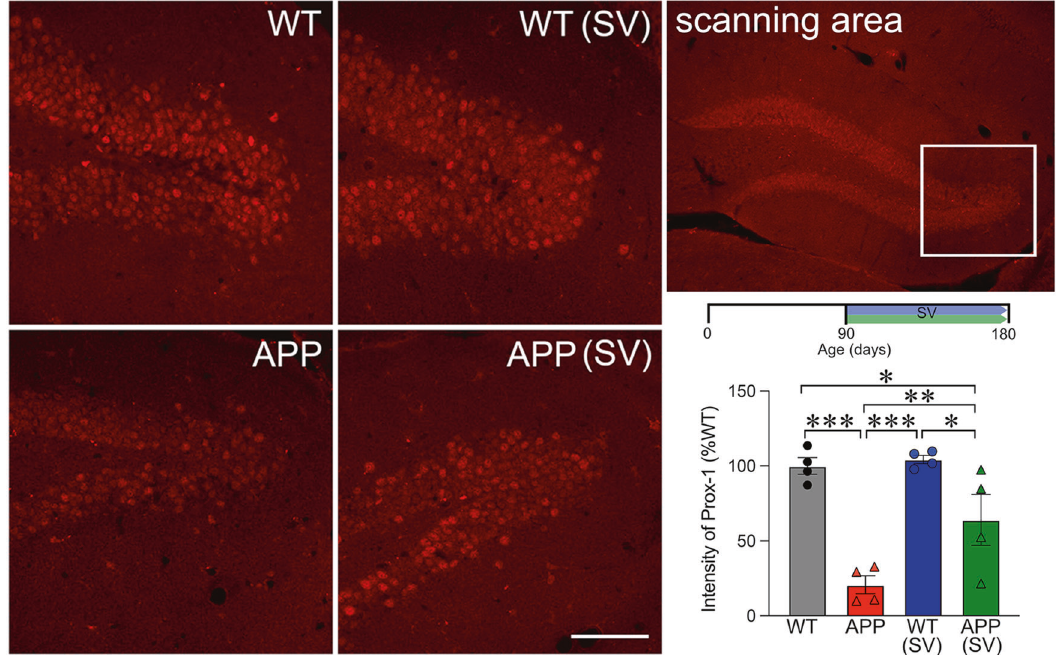
Fig. 7 SV increased Prox1 expression in granule cells of APP mice. The white box in the top right panel shows the confocal scanning area for Prox1 immuno fl uorescence staining in the dentate gyrus granule cell layer. Prox1 protein levels were drastically reduced in granule cells from APP mice compared to WT controls. Although SV treatment (timeline shown on top of bar graph) signi fi cantly increased Prox1 levels in treated APP mice, they still remained signi fi cantly lower than those of WT mice. ( n = 4 – 5 mice/group) *** p < 0.001, using two-way ANOVA followed by Newman-Keuls post-hoc test. Scale bar = 75